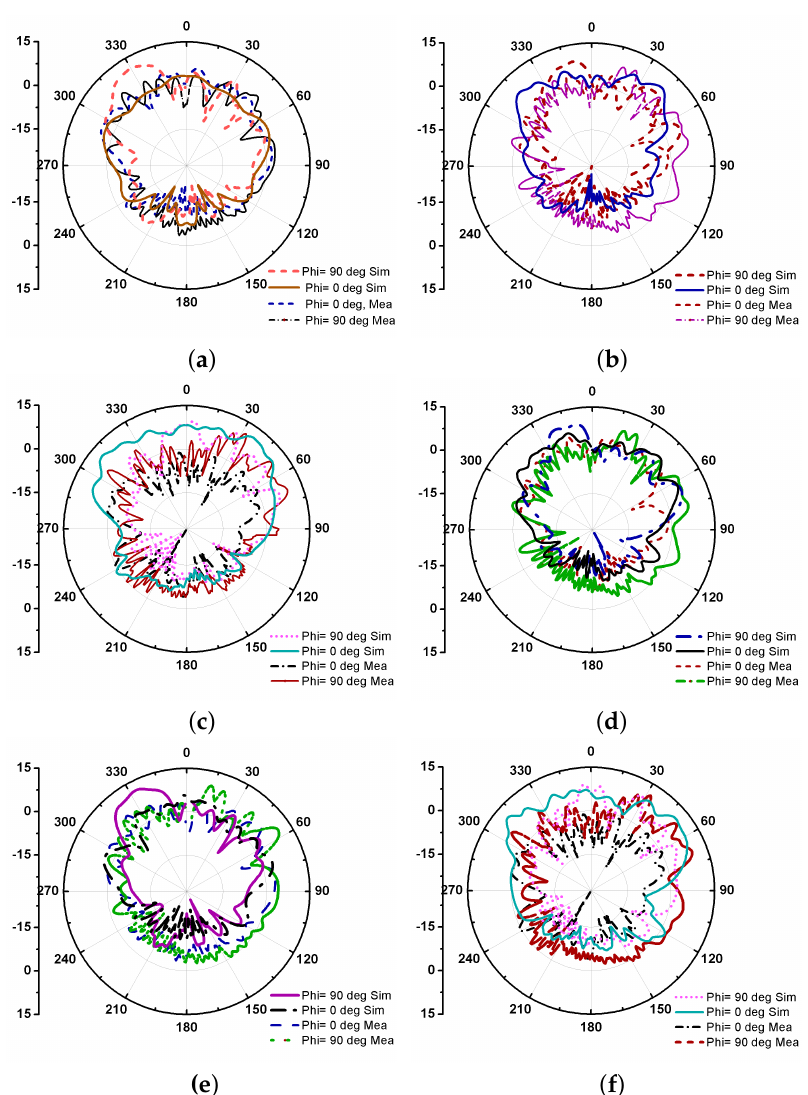
Figure 10. Radiation patterns of MIMO antenna: ( a ) port-1/28 GHz; ( b ) port-1/33 GHz; ( c ) port-1/38 GHz; ( d ) port-2/28 GHz; ( e ) port-2/33 GHz; ( f ) port-2/38